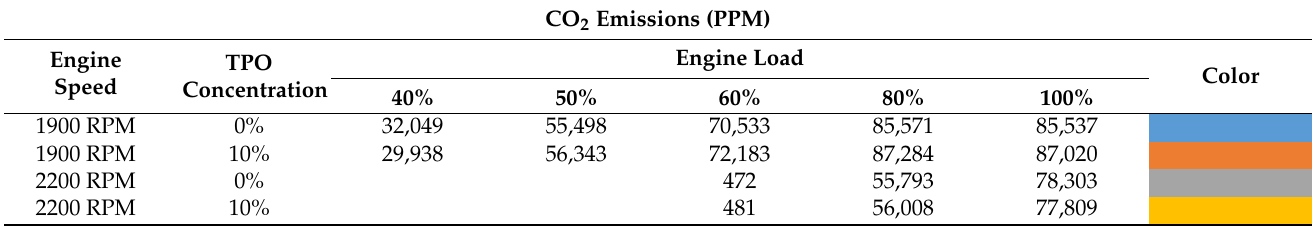
Table 6. Measured CO 2